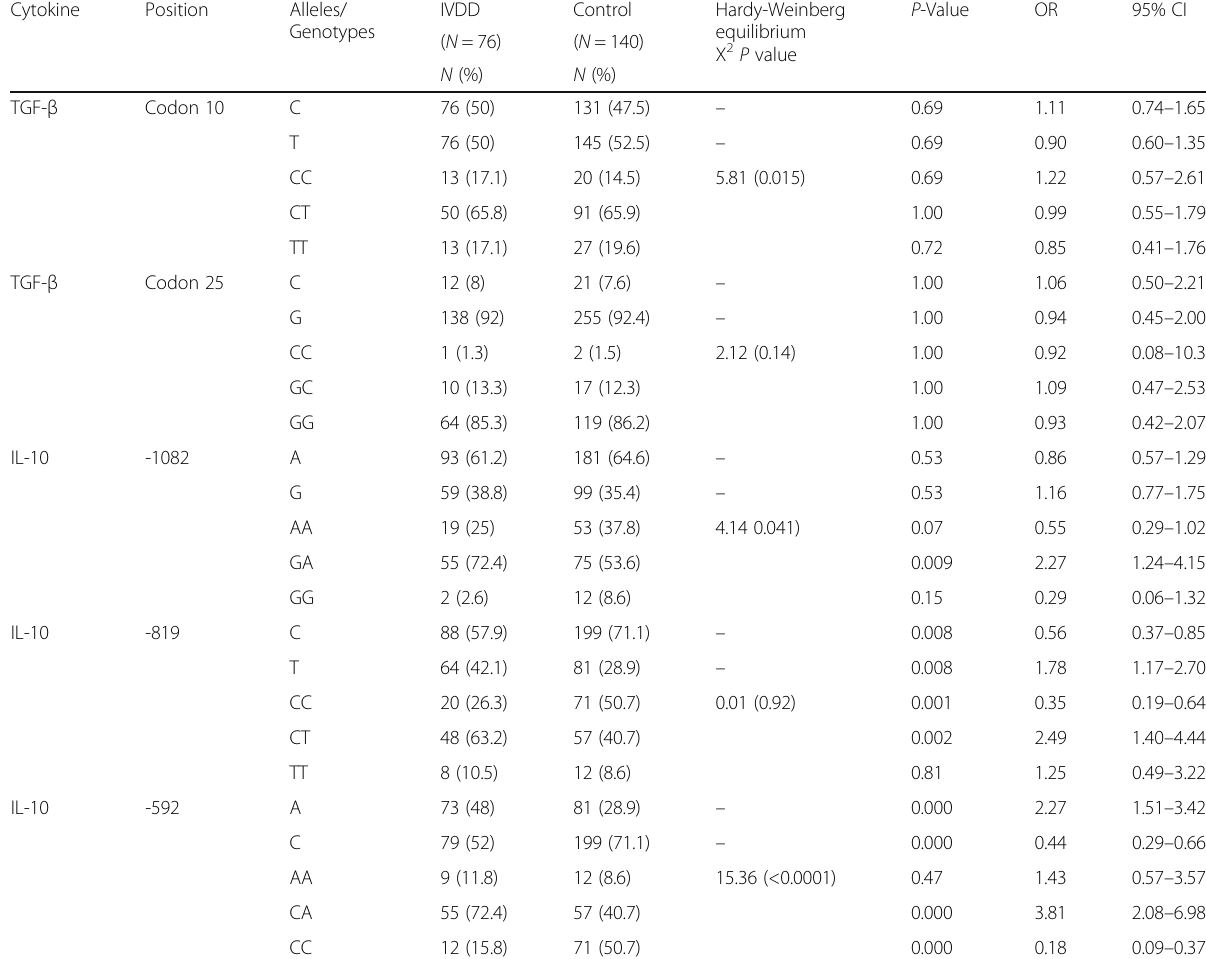
Table 2 IVDD-Control allele and genotype frequency comparison Cytokine Position Alleles/ IVDD Control Hardy-Weinberg Genotypes equilibrium TGF- β Codon 10